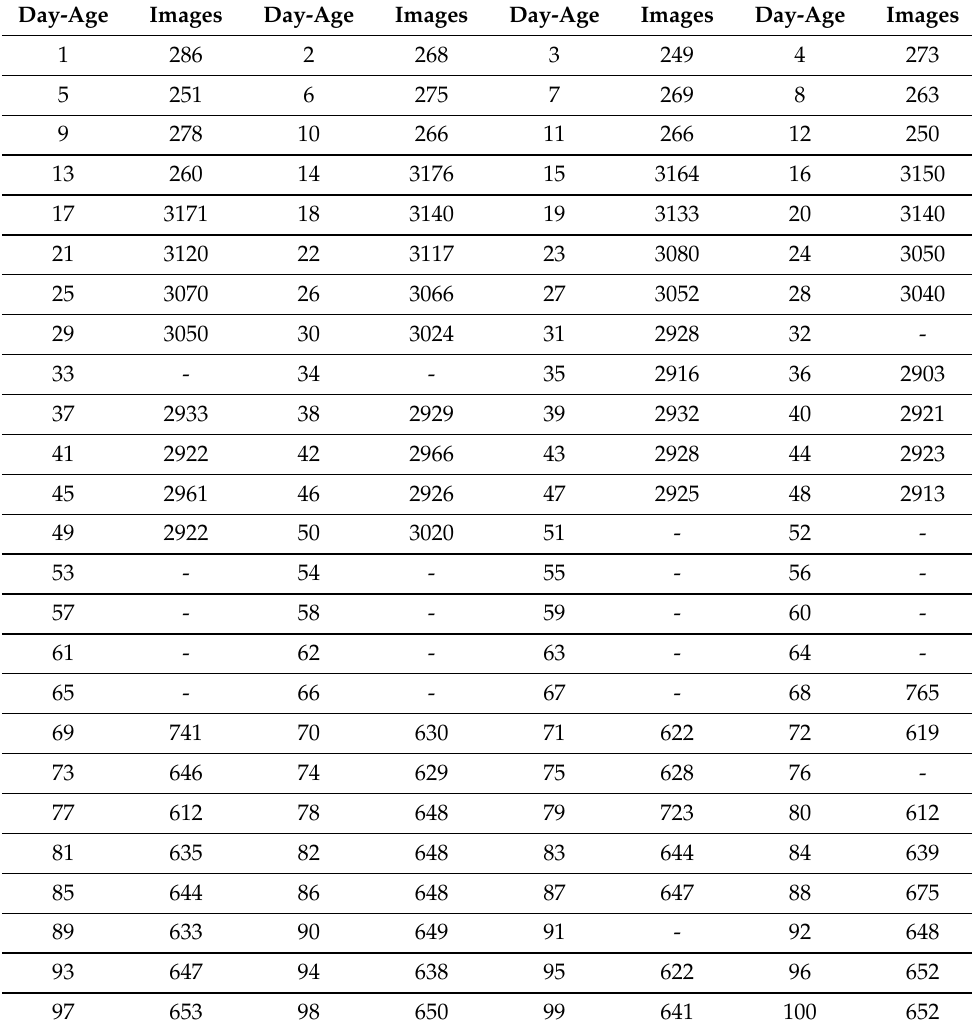
Table 2. Distribution of datasets between